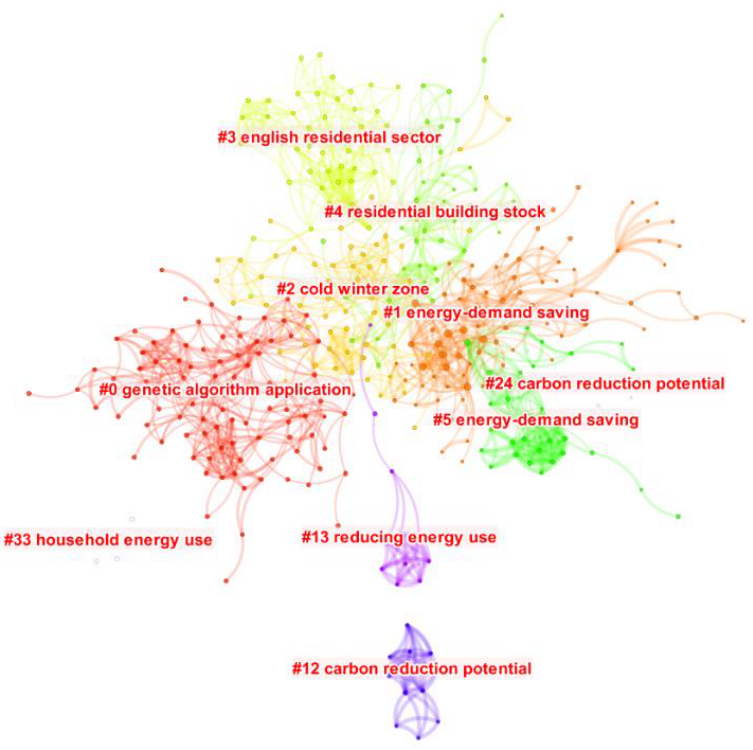
Figure 5. The cluster of co-citation analysis.